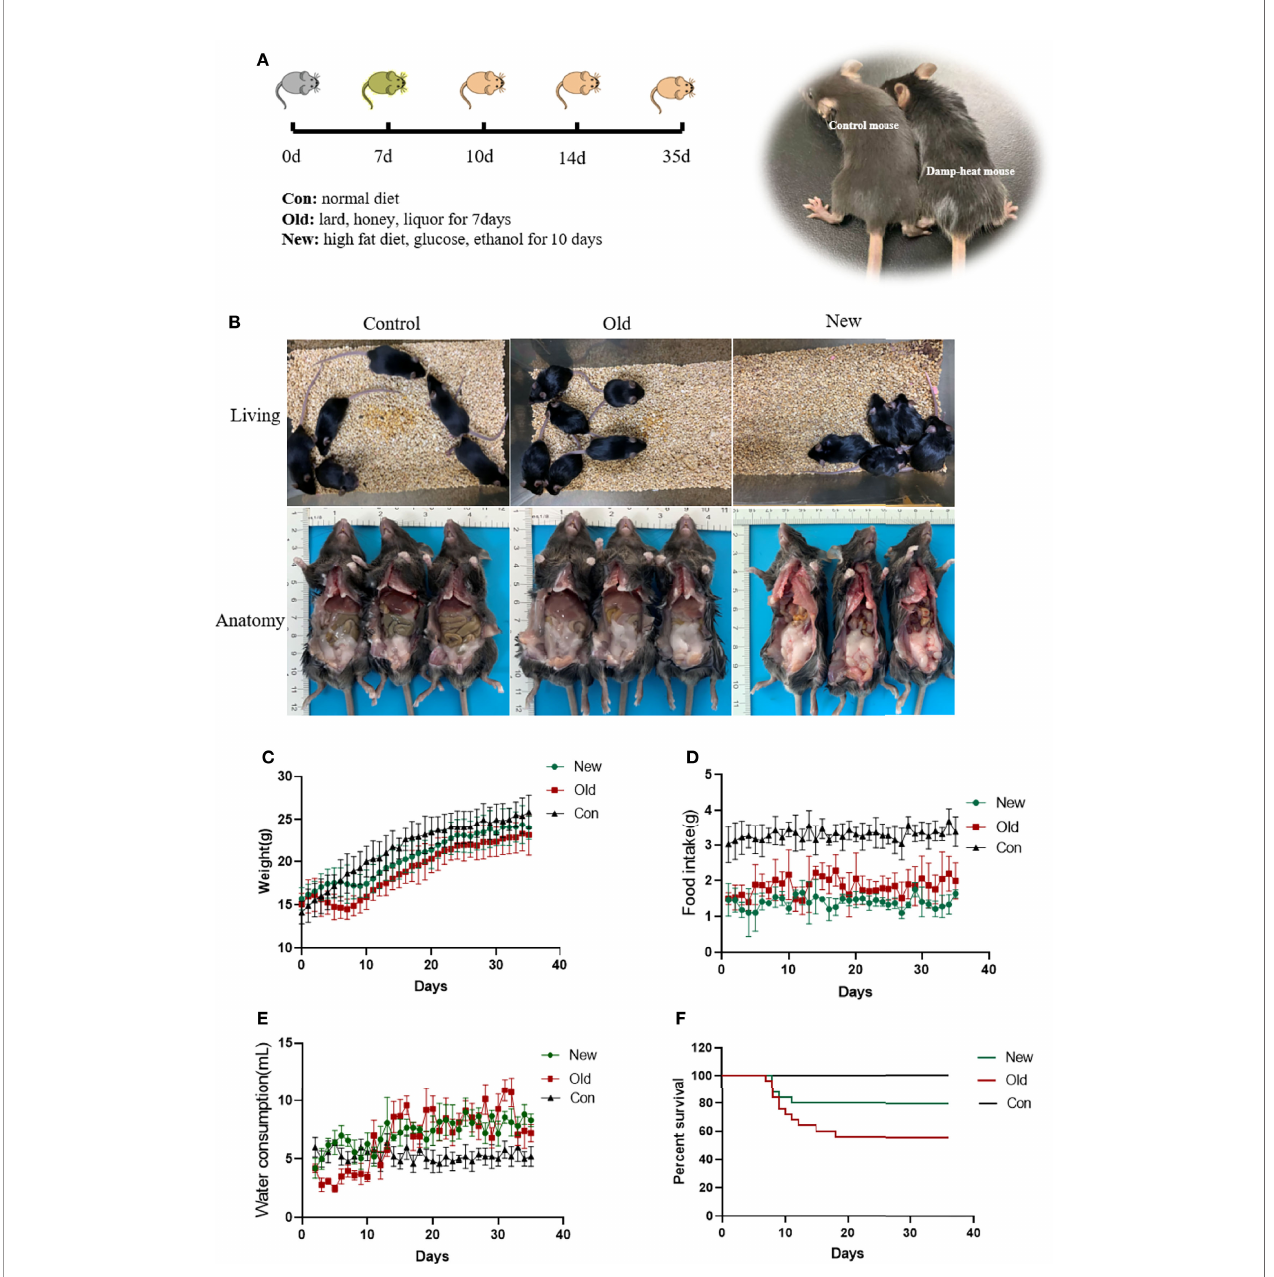
FIGURE 2 | A damp-heat syndrome mouse model was established with the new and old methods. (A) Diagram for establishing a mouse model of damp-heat syndrome. (B) Activity status and anatomical view of mice in the three groups. (C) Body weight of mice over time. (D) Food intake of mice in the three groups over time. (E) Water consumption of mice in the three groups over time. (F) Survival of mice in the three groups over